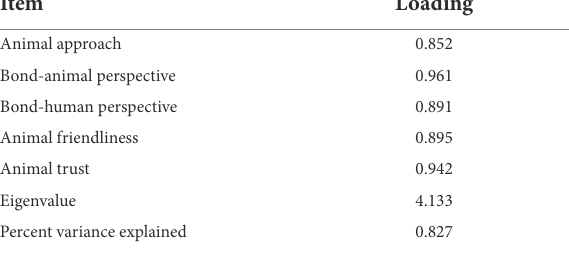
TABLE 4 Human-animal bonds items factor structure.